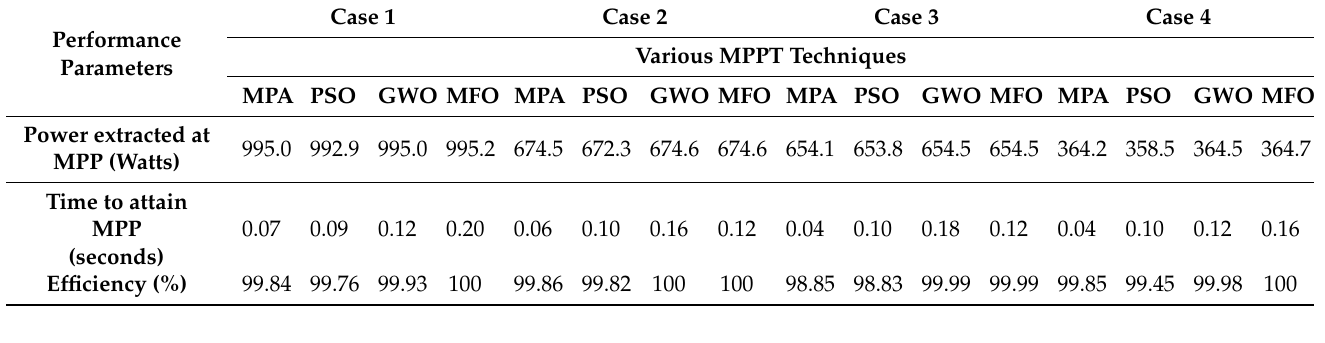
Table 3. Comparison between MPA, PSO, GWO, and MFO techniques for different test cases. Figure 10. Duty along with PV power, current, voltage for MPA, PSO, GWO and MFO during case 4.